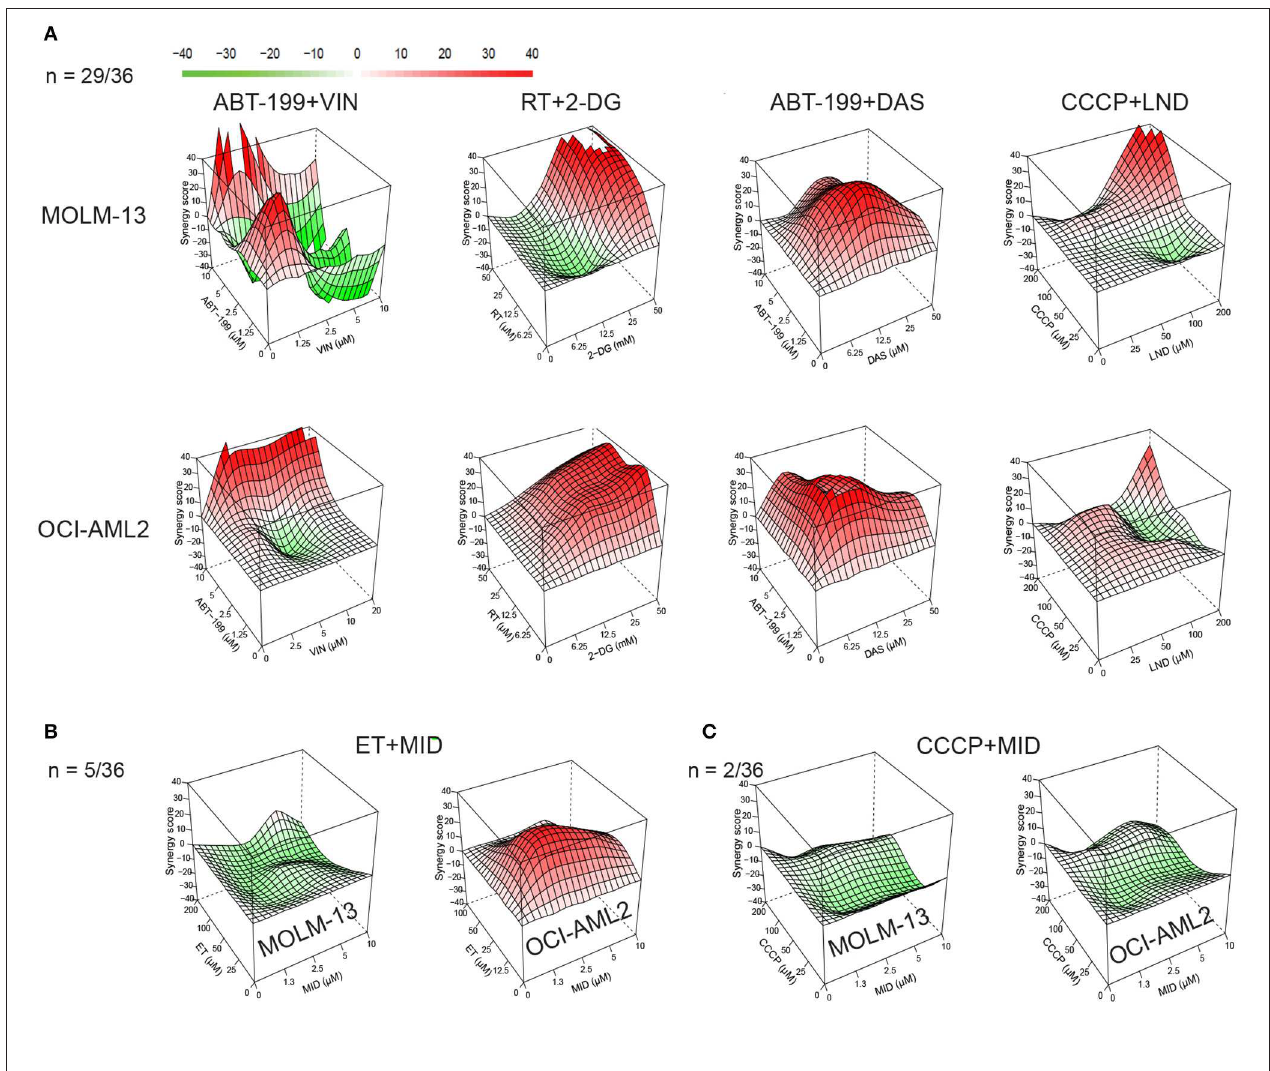
FIGURE 2 | Synergy landscapes for mitocan-based AML drug combinations. Drug combination landscapes were built using Bioconductor package “synergyfinder.” One representative replicate (with maximal synergy closest to its average value) is shown. (A) Examples of drug combinations ( n = 29/36), synergistic against AML cell lines. Shown are drug combinations having highest ( > 70) cumulative synergy against MOLM-13 (top) and OCI-AML2 (bottom) cells. (B) Example of drug combination with opposite profiles in MOLM-13 and OCI-AML2 ( n = 5/36). (C) Examples of antagonistic drug combinations for MOLM-13 (left) and OCI-AML2 (right) cells ( n = 2/36). Drug combination landscapes: z-axis , synergy score (ranges from − 40, green, to + 40, red); x/y-axes , drug1/drug2 concentration range, respectively. For specific drug names and drug concentrations, refer to Table S4